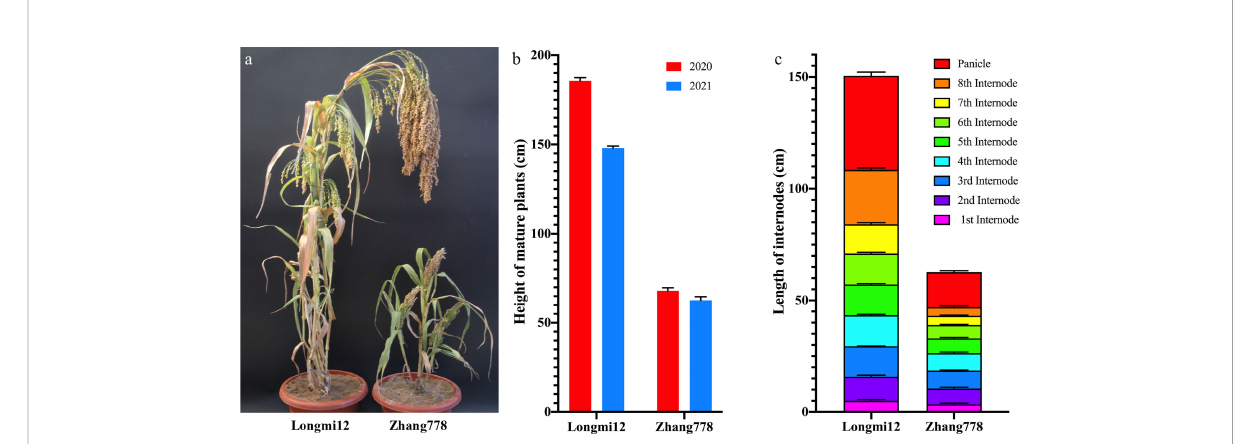
FIGURE 1 Plant height performance of Longmi12 and Zhang778. (A) Mature plants of Longmi12 and Zhang778. (B) Comparison of the height of mature Longmi12 and Zhang 778 plants across 2 years. (C) Comparison of the length of each internode from Longmi12 and